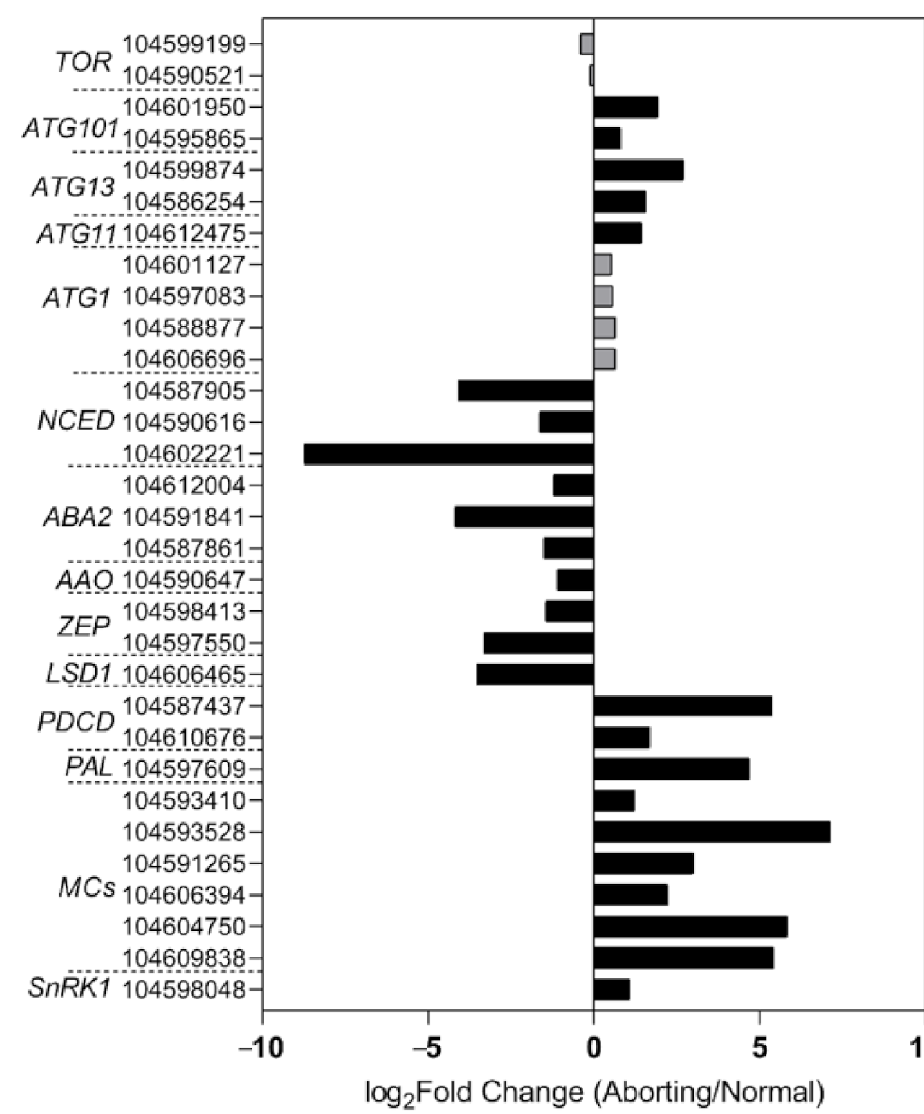
Figure 5. High-throughput sequencing analysis of the normal and aborting lotus flower buds. After growing for 2 months, 2- to 3 -cm-long normal or aborting flower buds were excised for high-throughput sequencing analysis. Black columns indicate significantly changed genes (fold change ≥ 2, adjust p value ≤ 0.001) between the normal and aborting flower buds. The numbers are the NCBI accession numbers of corresponding genes. Color scale indicates the expression level of genes in log 2 (aborting/normal)-transformed